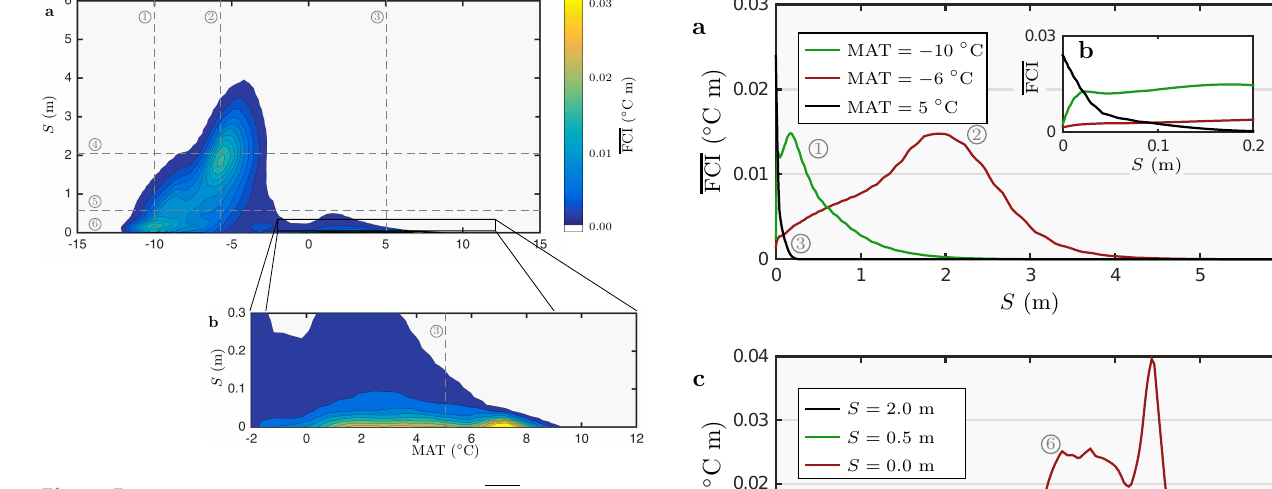
Figure 5. The integrated frost-cracking intensity, FCI, as a function of mean annual temperature, MAT, and sediment thickness, S . Each point in the contour plot corresponds to the annually integrated FCI for a particular combination of MAT and S . The contour plot was constructed from 8100 such combinations. The porosity of both sed- iment and bedrock is assumed to be 100% saturated by water. The dashed lines with numbers correspond to transects that are shown in Fig. 6. The inset shows the FCI for positive MATs in detail. Here FCI is strongly limited by sediment thickness and decays rapidly when S increases to more than a few centimetres.